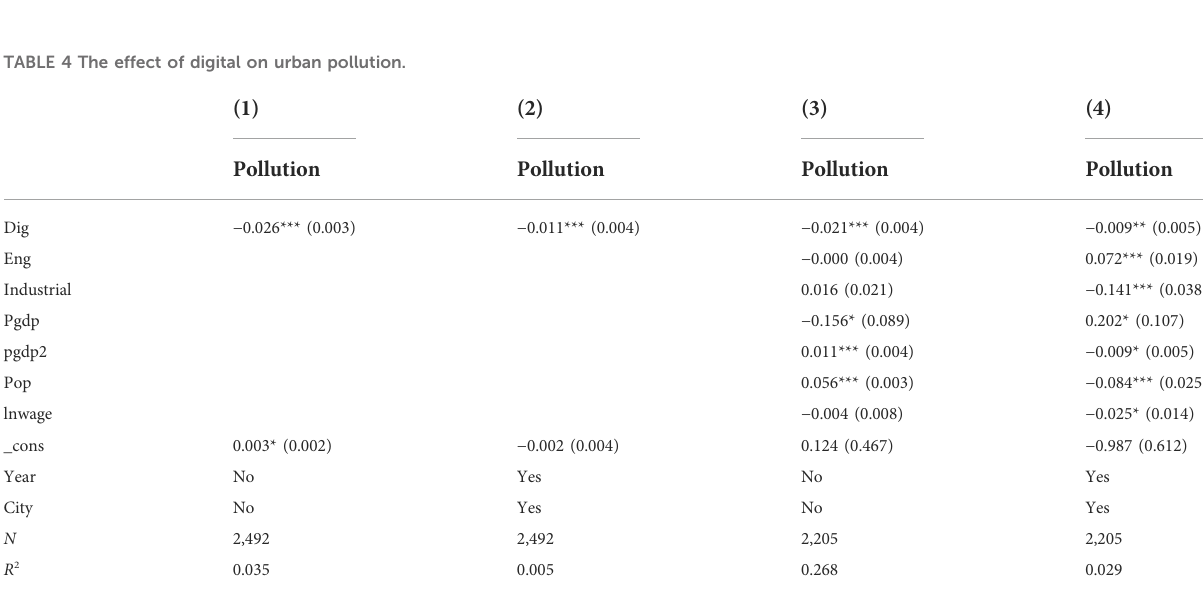
TABLE 4 The effect of digital on urban